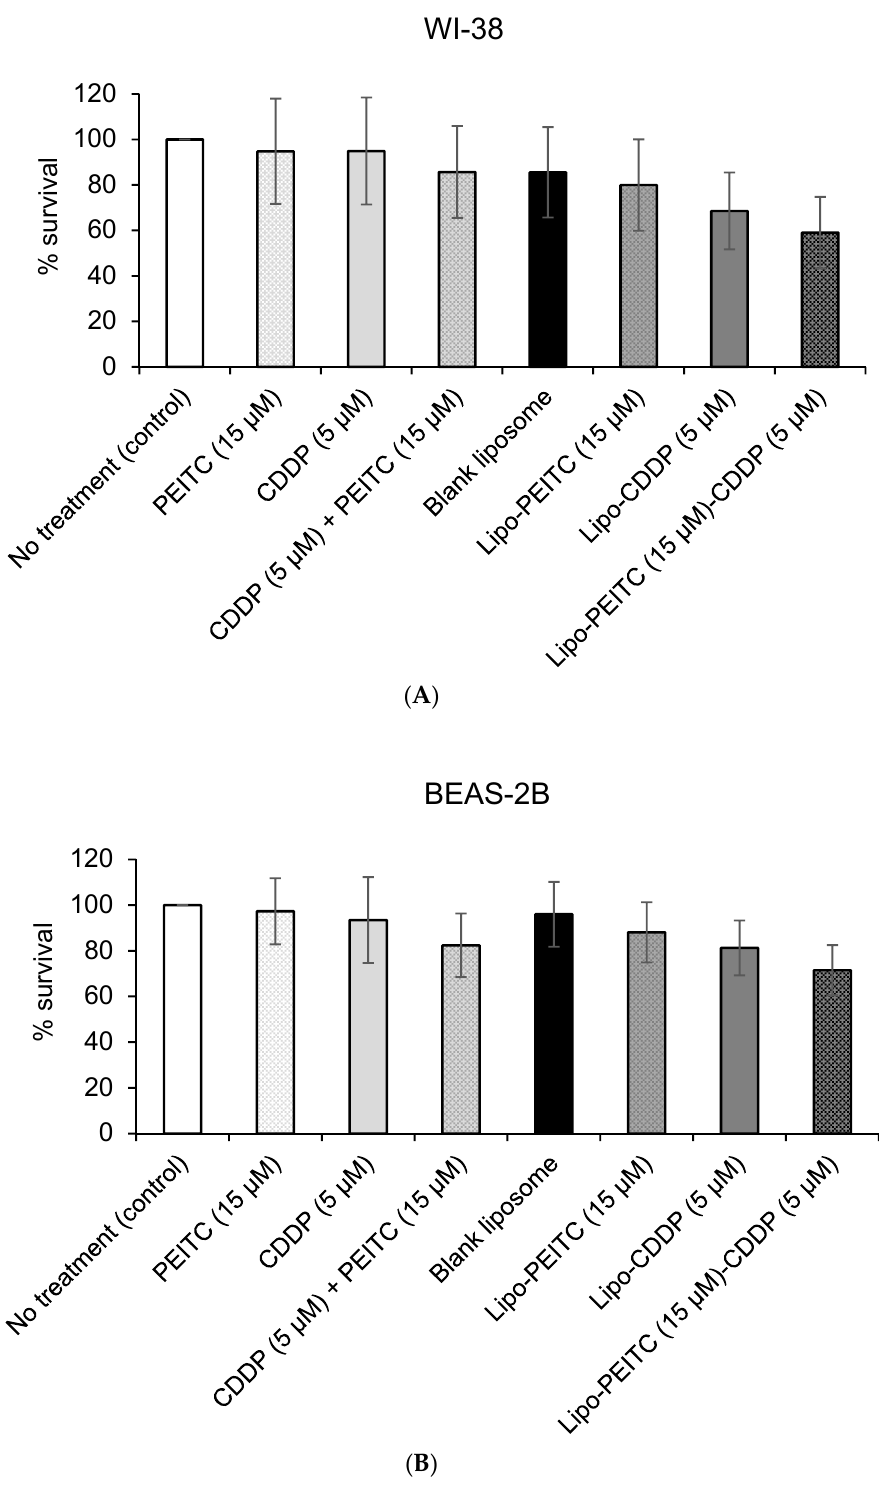
Figure 4. Percent survival of normal human lung cell lines ( A ) WI-38 (human diploid lung fibroblasts) and ( B ) BEAS-2B (human bronchial epithelial cells) treated with free cisplatin (CDDP) and phenethyl isothiocyanate (PEITC) and liposome-encapsulated compounds.